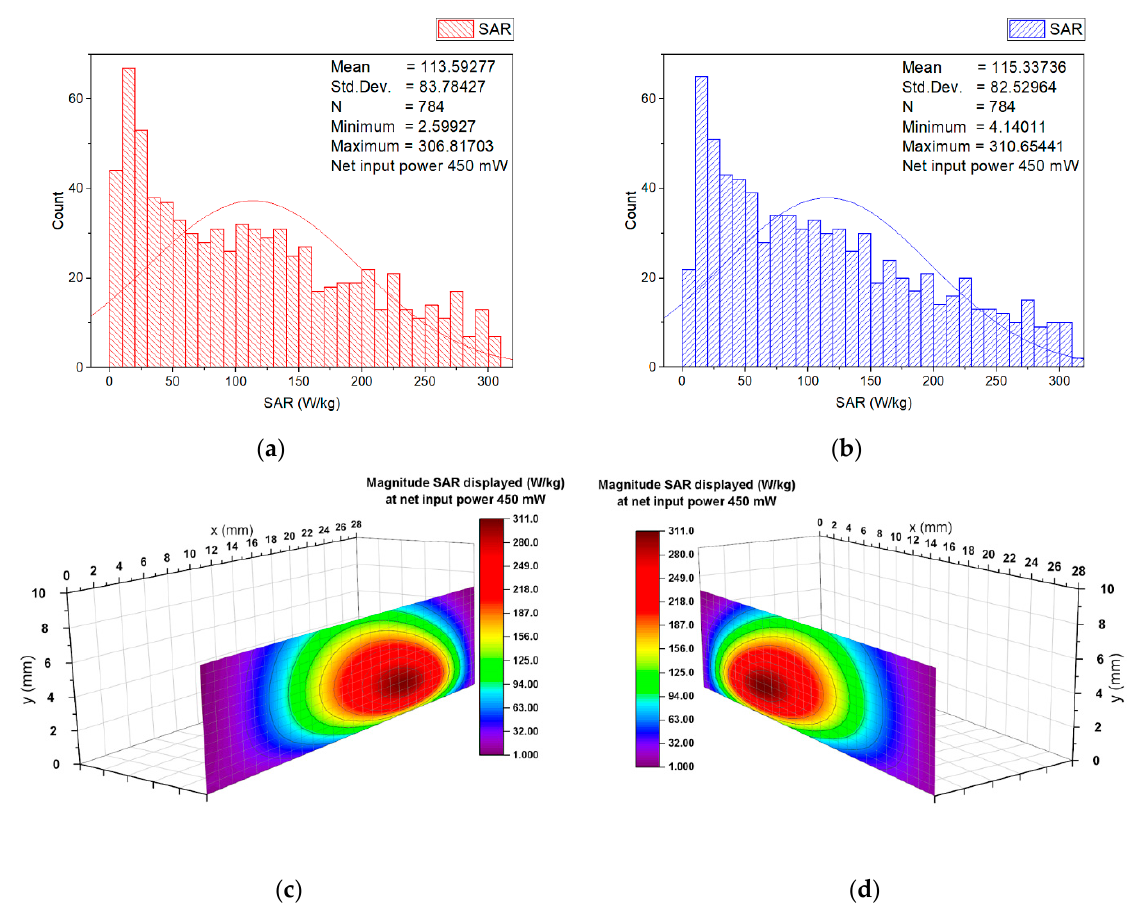
Figure 8. Histograms and descriptive statistics of SAR distribution at net input power of 450 mW for the erythrocyte suspensions in the cross-section of ( a ) left cuvette; ( b ) right cuvette; ( c ) left cuvette color-scale visualization of the SAR distribution; ( d ) right cuvette color-scale visualization of the SAR distribution. Table 4. Comparison of the maximum and minimum SAR values at two input powers of the wear- able antenna, at 2.41 GHz.